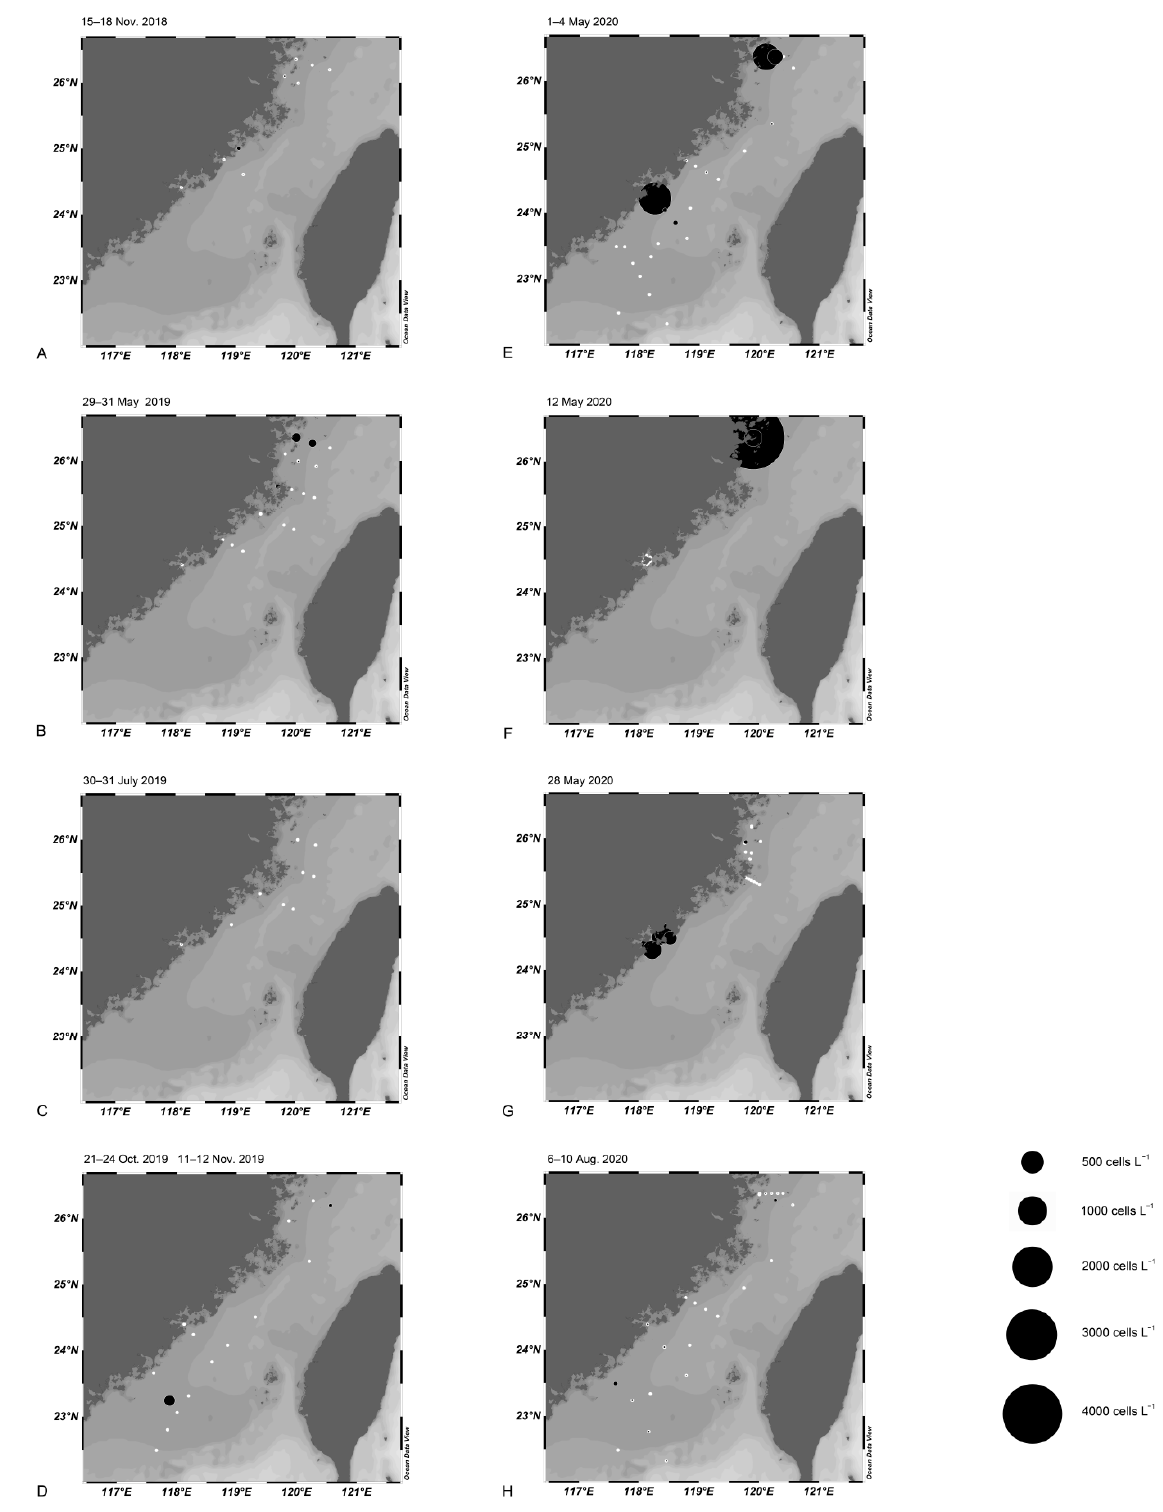
Figure 4. Cell abundance (cells L − 1 ) of Alexandrium pacificum determined by qPCR in water samples from the Taiwan Strait in November 2018 ( A ), May 2019 ( B ), July 2019 ( C ), October and November 2019 ( D ), May 2020 ( E – G ), and August 2020 ( H ). White dots represent collection sites where no cells were detected.